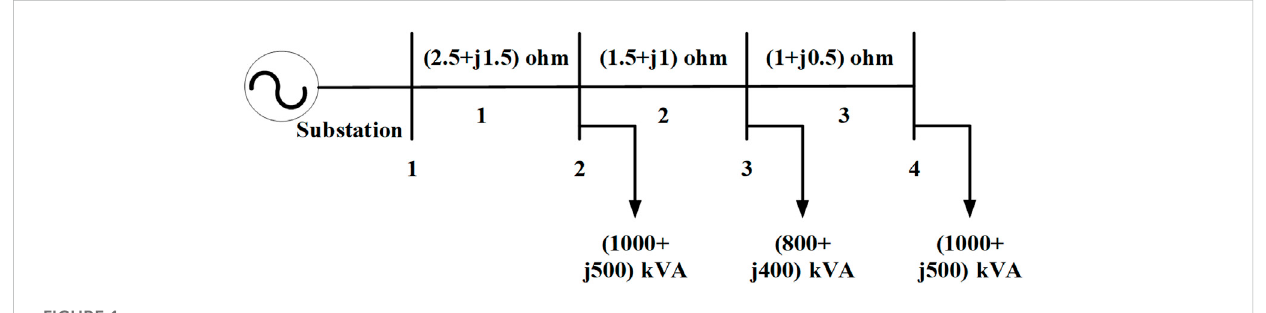
FIGURE 1 Single line diagram of 4-bus radial DS.